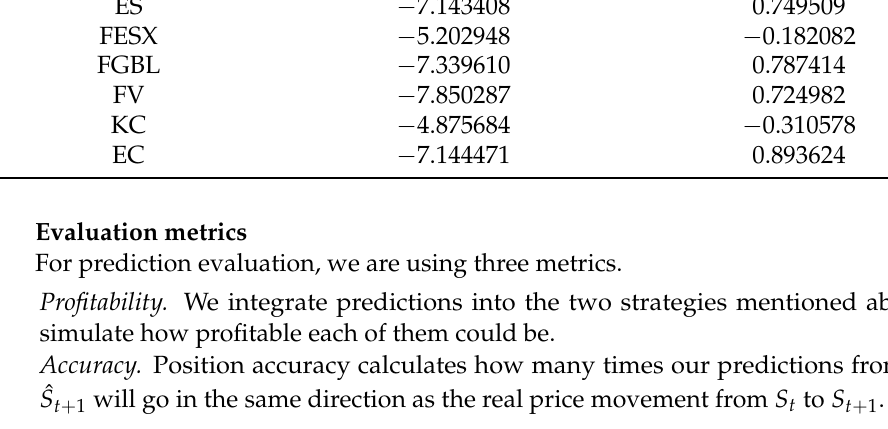
Table 2. Statistics of fractional differenced series ADF test results and correlation with original series. Symbol ADF